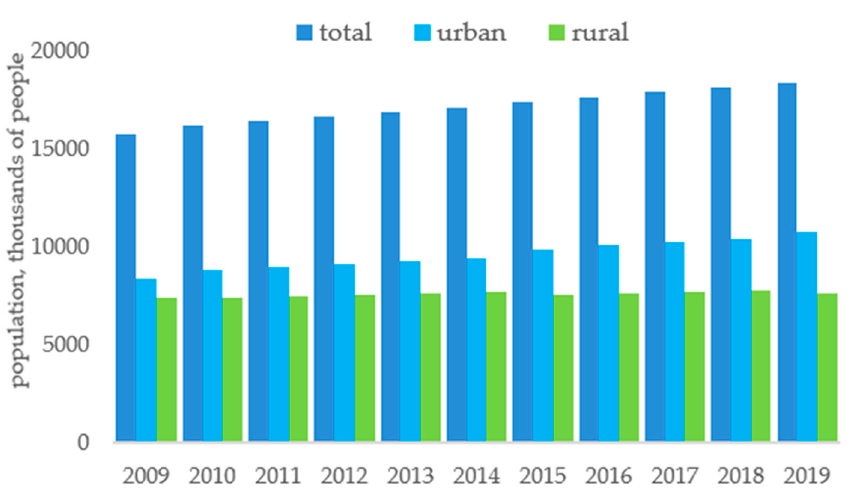
Figure 7. Population of the Republic of Kazakhstan. Source: Stat.gov.kz, 2021. Available online: https://stat.gov.kz/ (accessed on 26 May 2021).